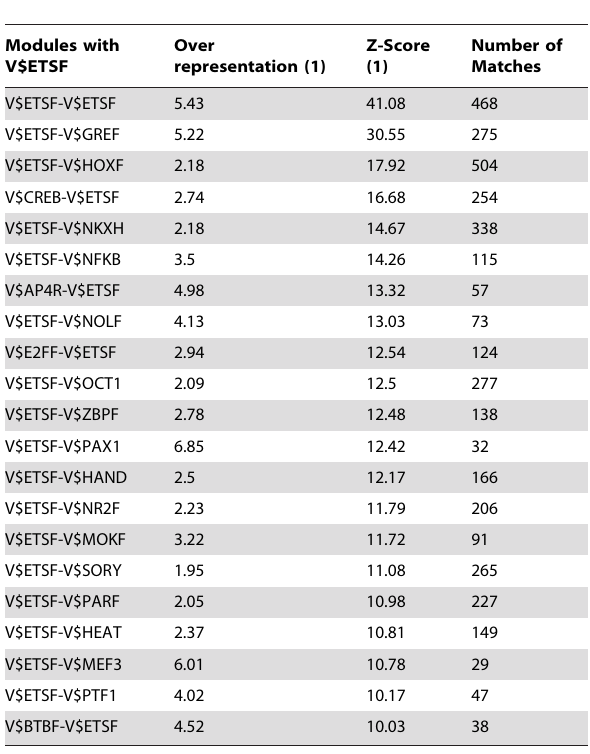
Table 3. Transcription factor modules containing an ETSF binding site in regions other than GGAA microsatellites.